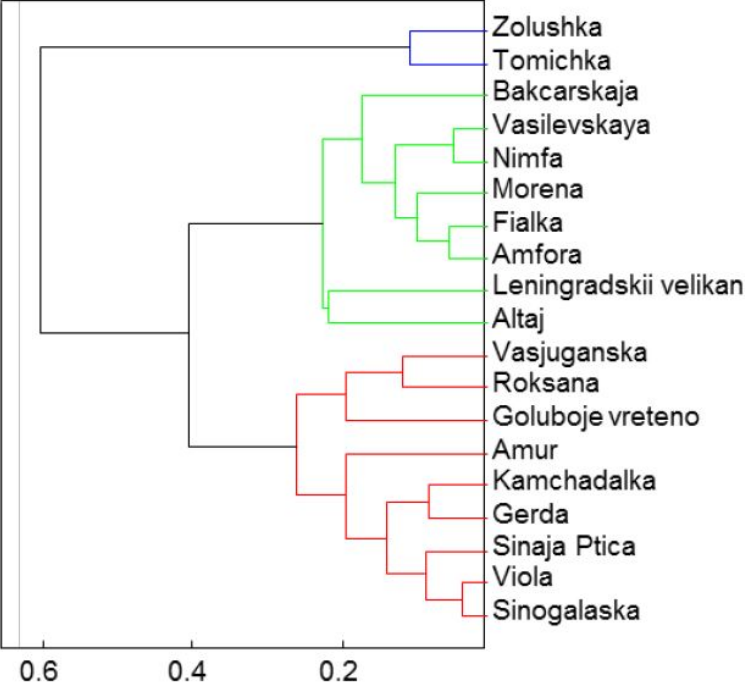
Figure 6. The cluster analysis of antioxidant activity represented by three principal